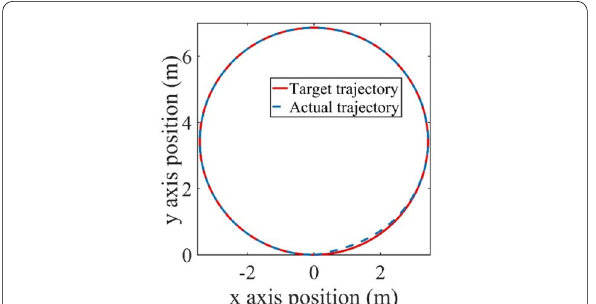
Figure 18 Target and actual robot trajectories